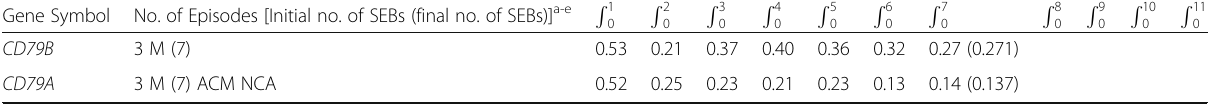
Table 10 Chromosome 17 ( − ) strand chromatin cluster of differentiation pre-B-cell receptor gene, CD79B , and chromosome 19 (+) strand chromatin pre-B-cell receptor gene, CD79A , sequential esebssiwaagoT Q s to final 2-digit (and 3-digit) esebssiwaagoT Q Gene Symbol No. of Episodes [Initial no. of SEBs (final no. of SEBs)] a-e